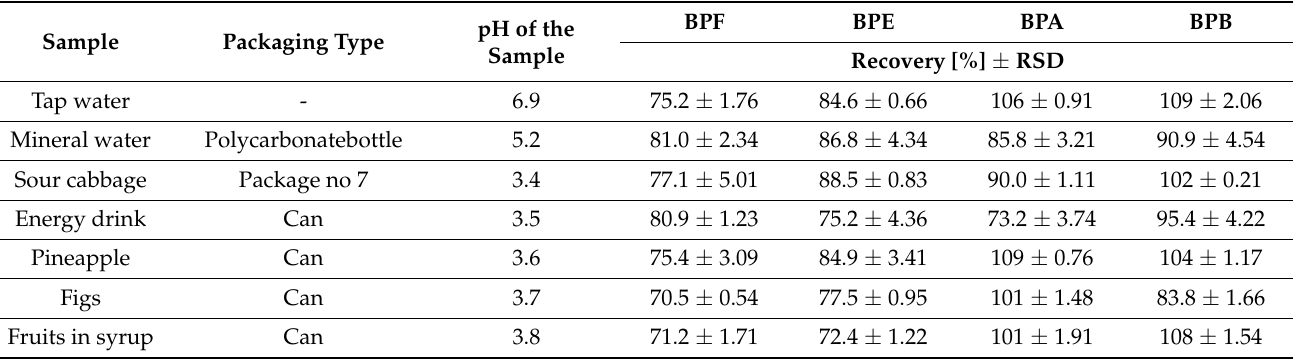
Table 1. Recoveries of BPF, BPE, BPA and BPB in different liquid food samples spiked with 50 µ g · L − 1 of a standard mixture of four bisphenols using microgel as a sorbent for preconcentration. Data are means with RSD ( n =